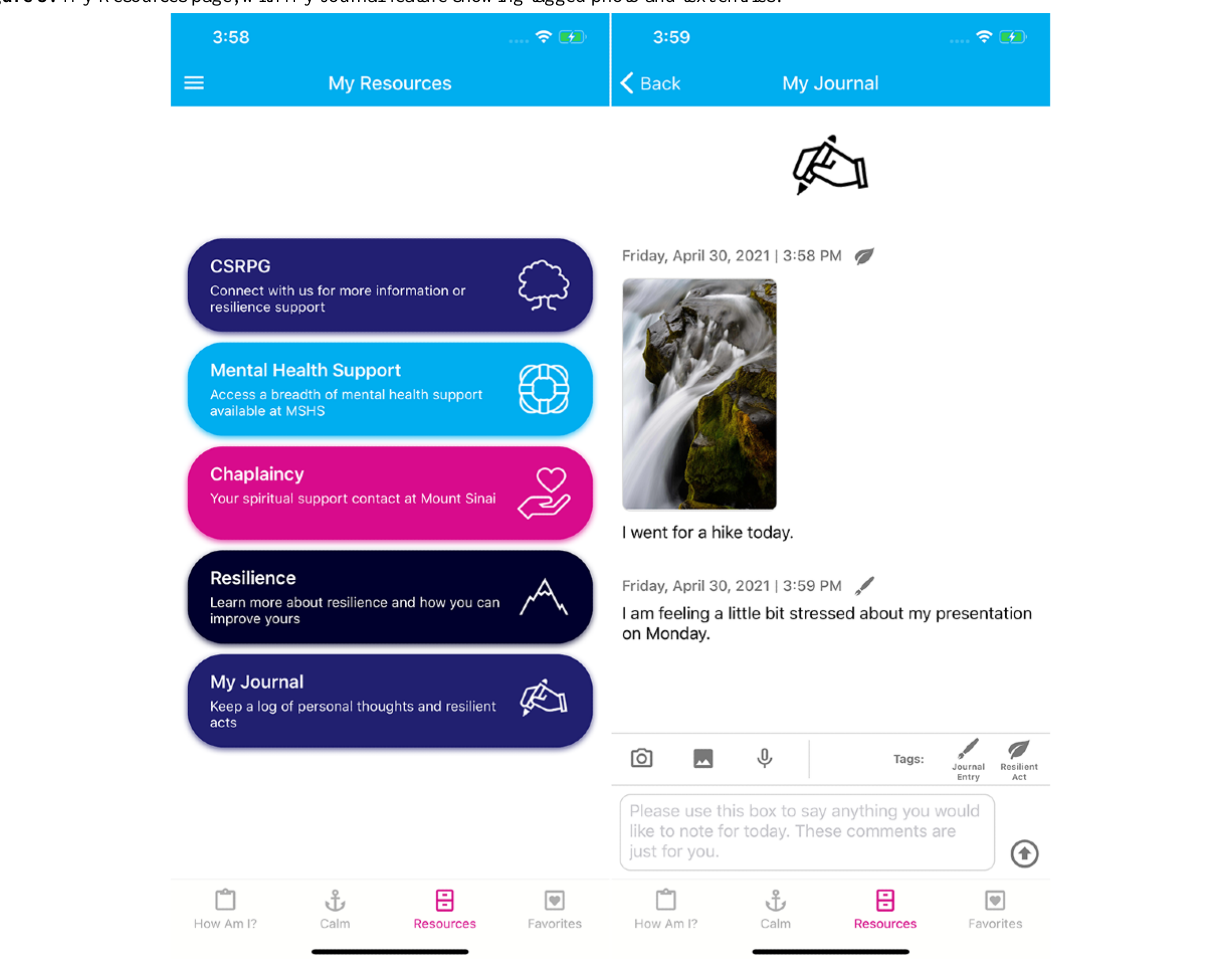
Figure 3. My Resources page, with My Journal feature showing tagged photo and text